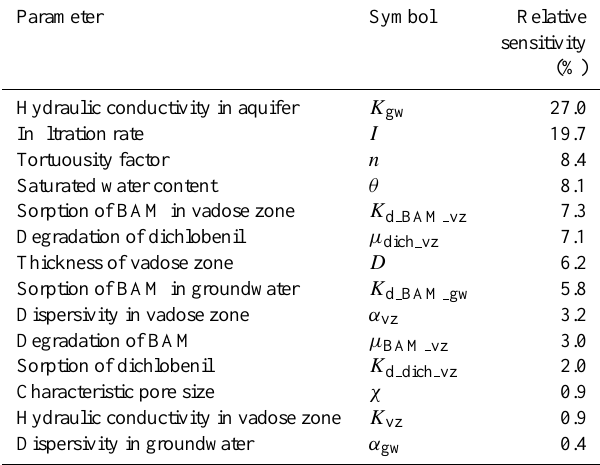
Table 4. Results of the sensitivity analysis for the concentration of BAM in the extraction wells. The sensitivities are expressed as percentages of the contribution to the total model uncertainty. The time step used in Eq. (5) was 180 days, and the time frame